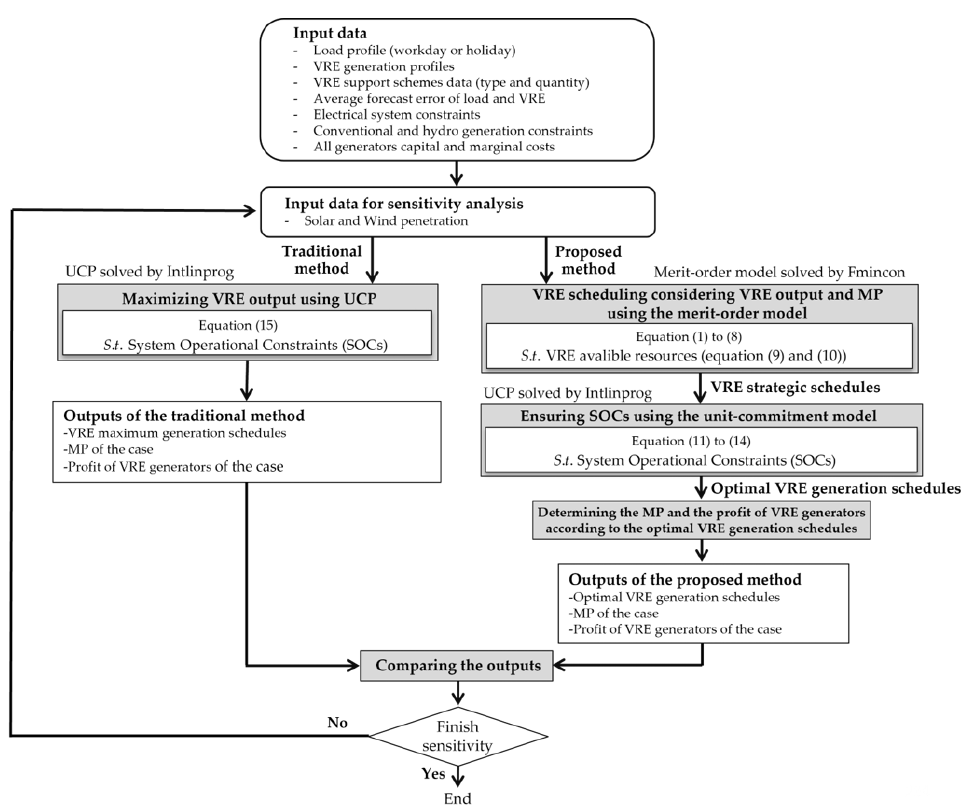
Figure 3. Flow chart of the optimization and sensitivity analysis.